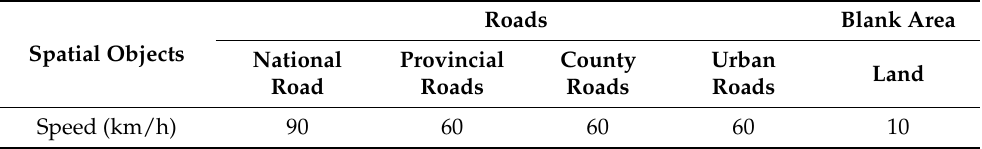
Table 2. Average road speed assignment in the BTH region. Roads Blank Area Spatial Objects National Road